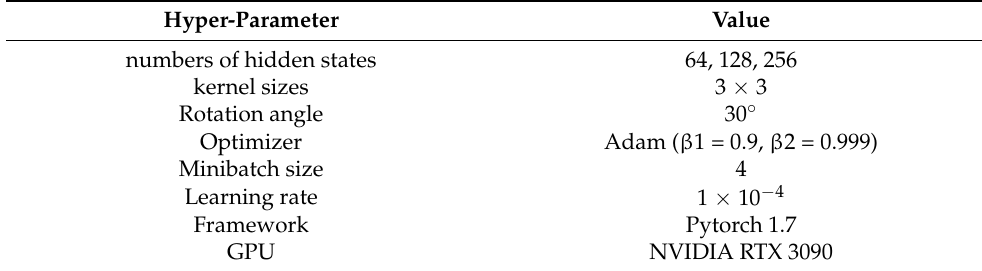
Table 3. Implementation details of the proposed